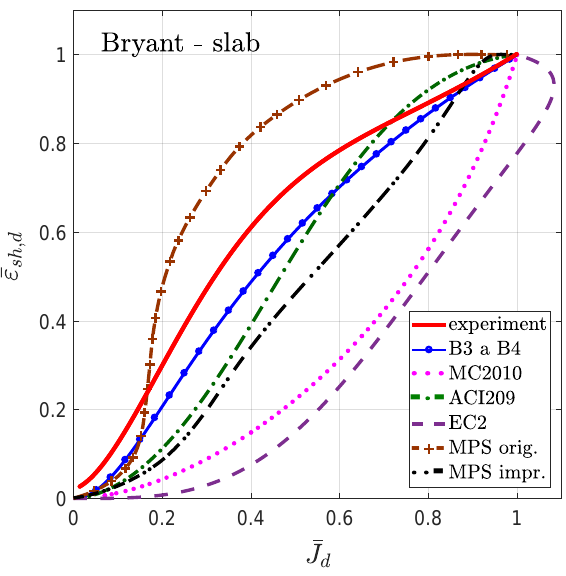
Figure 10. The comparison of the experimental data, prediction models and FE simulations of the Bryant’s experiment, 2 V/S = 75 mm